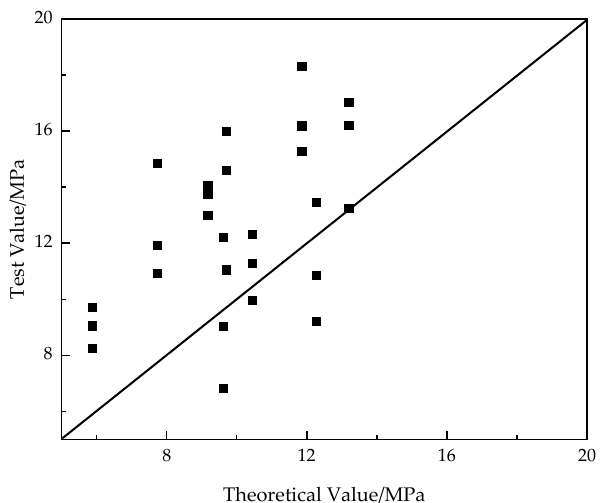
Figure 12. Comparison of bond strength calculated by the proposed formula and measured in the pull-out test.